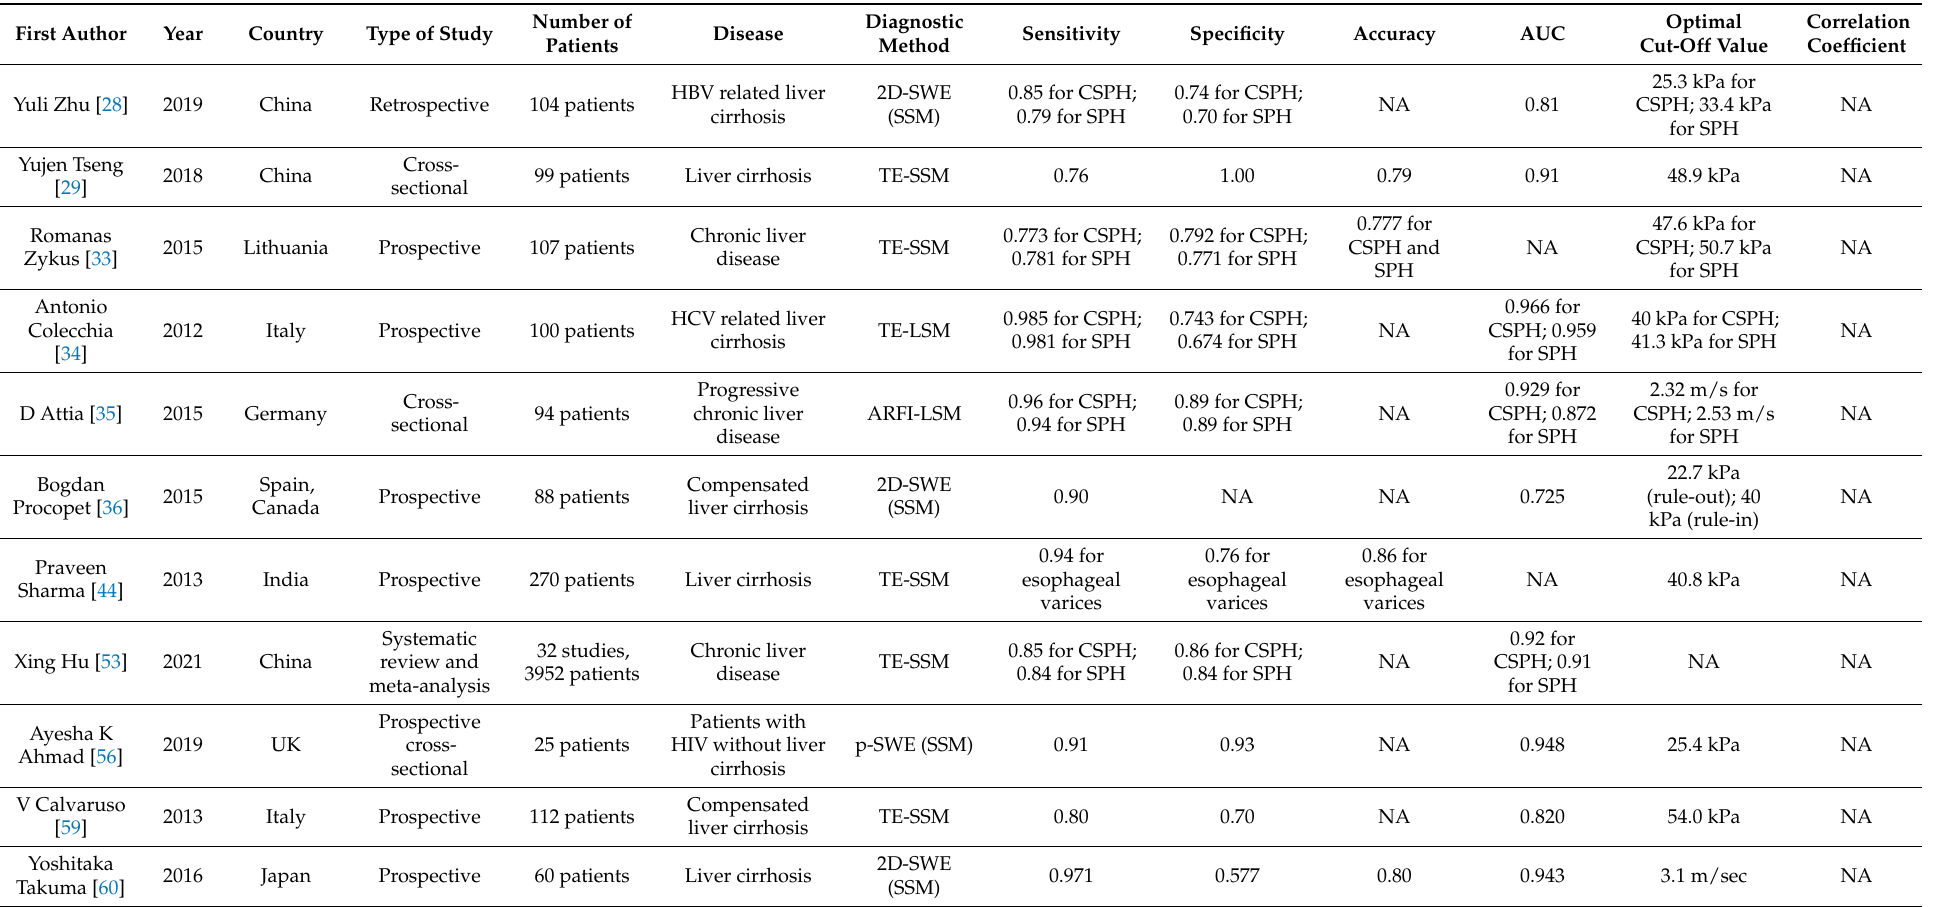
Table 2. Basic characteristics and diagnostic efficacy of SSM in assessing portal hypertension and gastro-esophageal